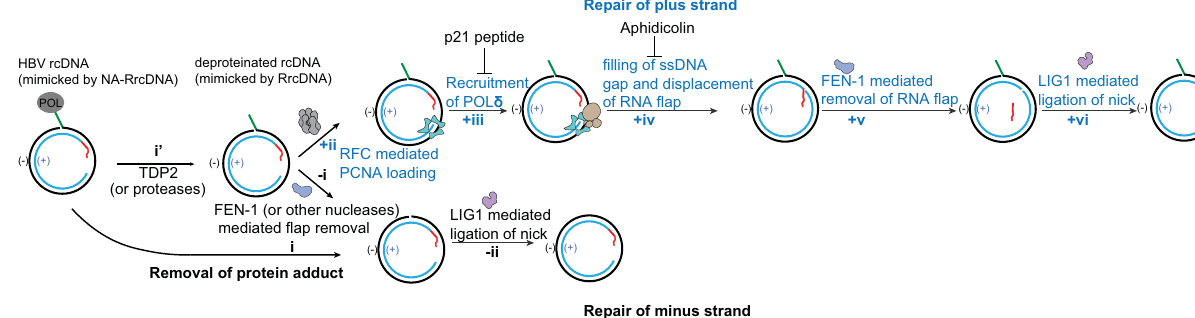
Fig. 7 A putative model of the repair of HBV rcDNA. The HBV polymerase adduct is fi rst removed by redundant factors FEN-1 (step i) and TDP2 (step i ’ ). The subsequent repair of the minus- and plus-strands are independent of each other, and the repair of the minus-strand only requires FEN-1 and LIG1 and proceeding, as steps -i and -ii. The repair of the plus-strand resembles Okazaki fragment synthesis, requiring more steps as shown from steps + ii to + vi. First, the RFC complex recognizes the 3 ′ end of the plus strand and loads PCNA to this primer-template junction (step + ii). PCNA then recruits POL δ via the PCNA-interacting peptide (PIP) sequence on POL δ (step + iii). This step can be speci fi cally inhibited by the p21 WAF1 peptide (KRRQTSMTDFYHSKRRLIFS). Subsequently, POL δ is activated by PCNA and fi lls the ssDNA gap and displaces the RNA primer on the 5 ′ -end of the plus- strand (step + iv). This step can be delayed by aphidicolin treatment. The displaced RNA primer adopts a fl ap structure that can be recognized